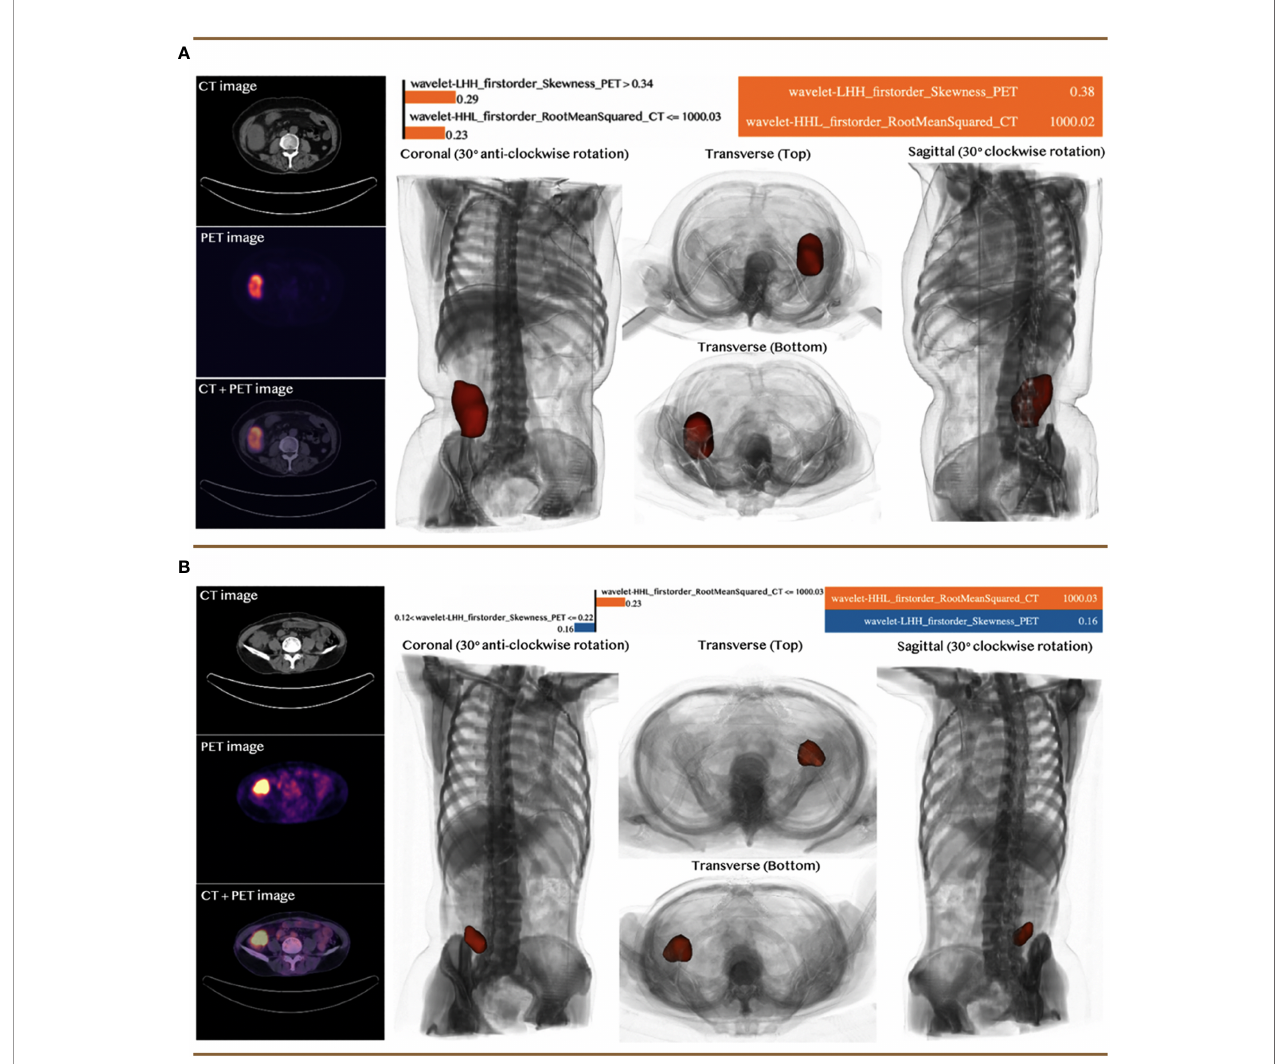
FIGURE 5 | Case studies with two patients: (A) a patient with MSI-H status and (B) a patient with MSI-L or MSS status. Both patients were predicted correctly by the machine learning model. The top right section for each panel indicated the feature value of the corresponding case and the approximated feature weights interpreted by LIME. The bottom right section demonstrated the 3D model constructed based on the input CT and PET images from different viewpoints, while the red section represented the tumor of the